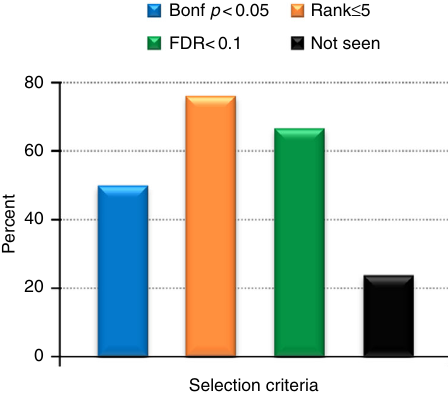
Fig. 2 Associations with positive controls. Positive control biomarker- phenotype pairs were identi fi ed a priori for 42 ARIC biomarkers. The histogram quanti fi es the percentage of pairs with Bonferroni p < 0.05, rank order value ≤ 5, false discovery rate (FDR) q < 0.1 or not seen by any of the criteria. Some pairs may fall into multiple